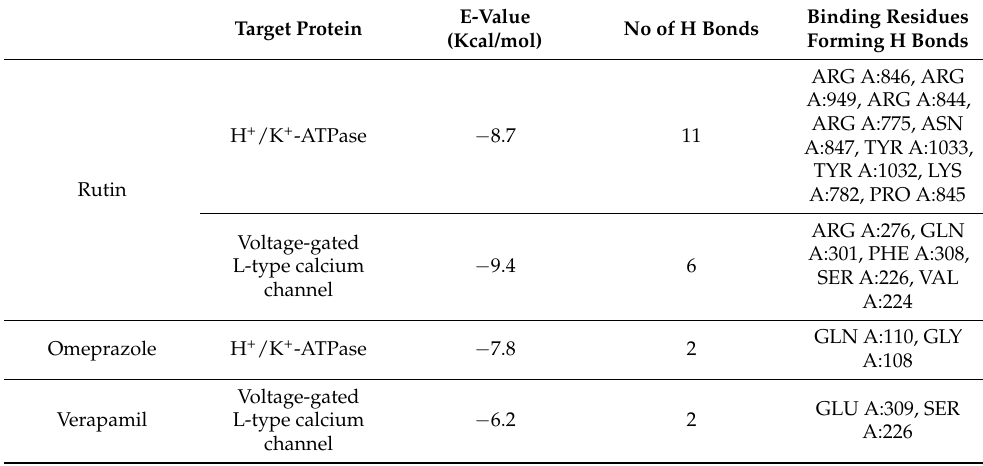
Figure 10. Inhibitory effect of Rumex hastatus crude extract (Rh.Cr), n-hexane (Rh.n-Hex), ethyl acetate (Rh.ETAC), an aqueous fraction (Rh.Aq), rutin and omeprazole against cyclooxygenase 2 (COX-2), tumor necrosis factor alpha (TNF- α ) and phosphorylated-nuclear factor kappa B (p-NFkB) expression in ethanol-treated rats gastric tissues, using the immunohistochemical technique. Values are expressed as mean ± SEM ( n = 3). One-way ANOVA with post-hoc Tukey’s test. ### p < 0.001 vs. saline group, *** p < 0.001 vs. ethanol group. Table 9. E-values (Kcal/mol) (binding energy values) and post-dock analysis of the best conforma- tional pose of rutin and standard drugs with targeted